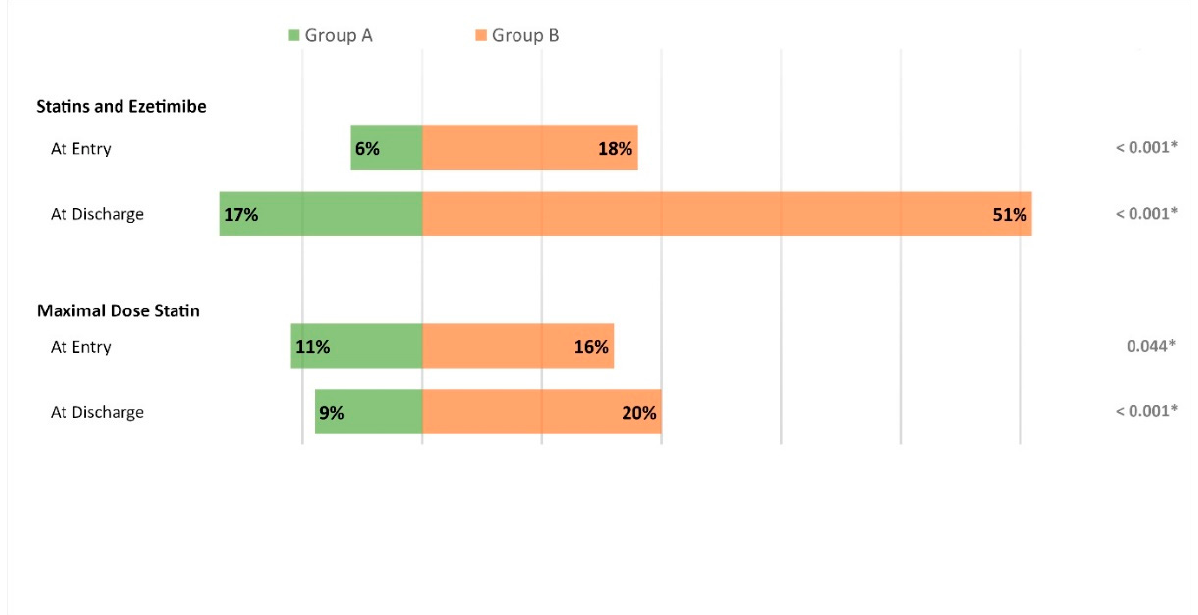
Figure 1. Mirror bar plot with prescription rates of combination therapy (statins and ezetimibe) as well as maximum dose statins at entry and discharge of cardiovascular rehabilitation (CR). The length of the columns represent the relative amount (in %) with regard to the entire cohort, green bars show Group A , orange bars represent Group B . Indication for significance = p Overall: 0.05 (indicated by *).